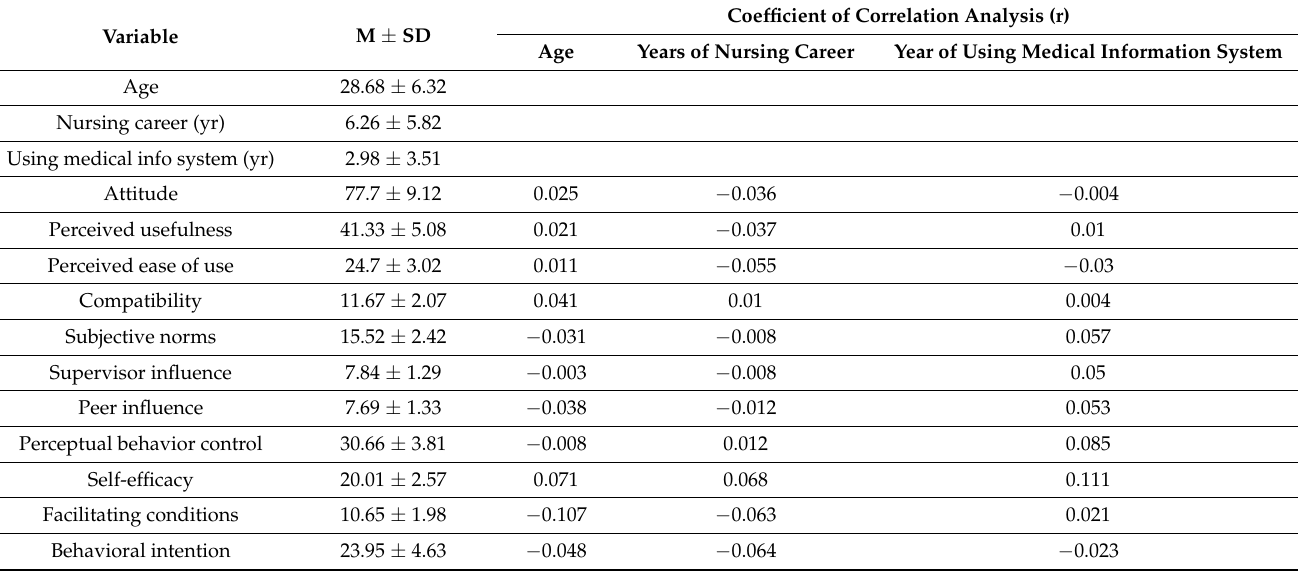
Table 3. Differences in characteristics of the study sample population and research